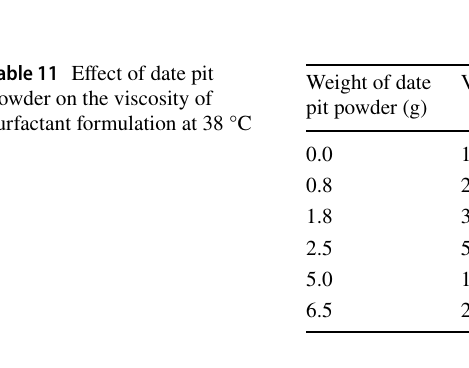
IFT interfacial